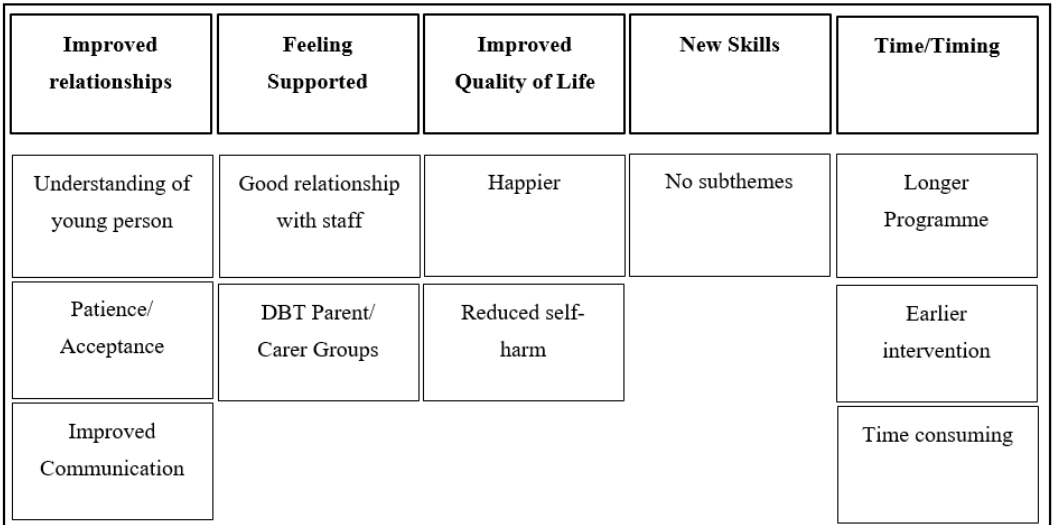
Figure 2. Thematic map representing parent and carer themes and subthemes.